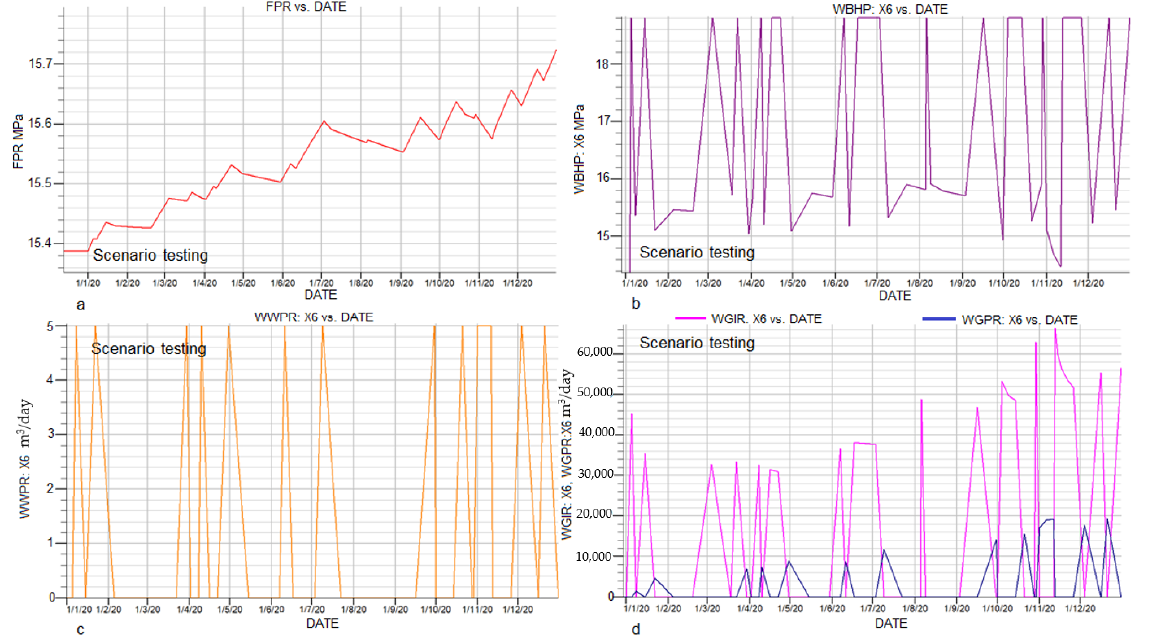
Figure 9. The fluctuation in electricity produced in Germany from renewable sources in 2017 is modelled into a future scenario testing case with limited water cut-off (5 m 3 /day). The excess of energy can be stored in UGS and can be used when needed. This schedule is helpful to understand in which month of the year energy can be stored as gas in UGS and in which month of the year this energy can be utilized when shortage occurs: ( a ) field pressure (FPR) profile for these cycles; ( b ) well bottom hole pressure (WBHP) of well X6; ( c ) well water production rate (WWPR) for well X6; and ( d ) well gas injection rate (WGIR) and well gas production rate (WGPR) for well X6.